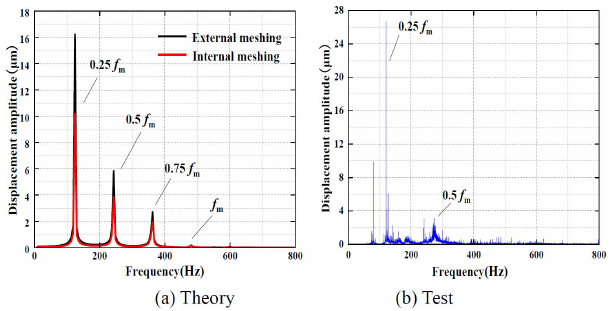
Figure 16. Frequency domain diagram of the vibration displace- ment at n = 2000rpm.